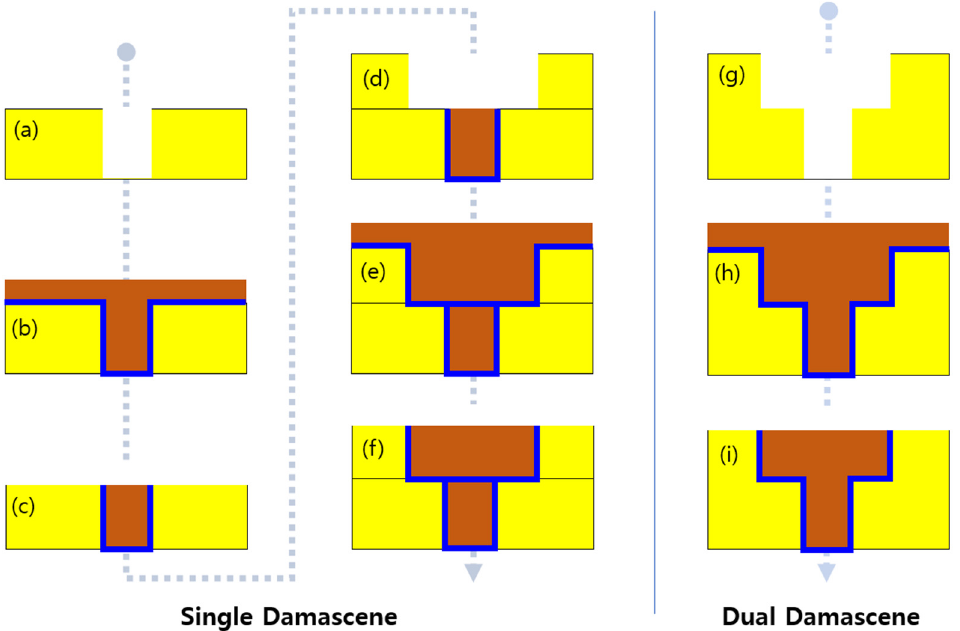
Figure 2. Process comparison of the ( a − f ) SD and ( g − i ) DD schemes: ( a ) etching of the via in the deposited ILD, ( b ) filling of the via with Cu, ( c ) CMP of the excess Cu from the via, ( d ) etching of the trench in the deposited ILD, ( e ) filling the trench with Cu, ( f ) CMP of the excess Cu from the trench, ( g ) trench/via etching in the ILD, ( h ) filling with Cu, and ( i ) CMP of the excess Cu.